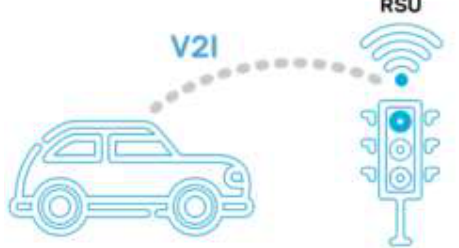
Figure 2. ©V2I communication Copyright 2017, 5GAA